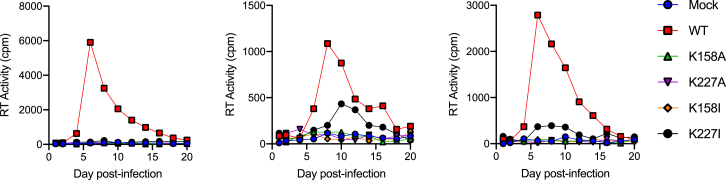
Capsid Mutants Prevent Efficient Replication in PBMCsPBMCs from three donors were infected with viruses carrying capsid mutations K158A, K158I, K227A, or K227I for 2 h. Cells were cultured over 20 days and supernatants sampled every other day and assayed for RT activity.